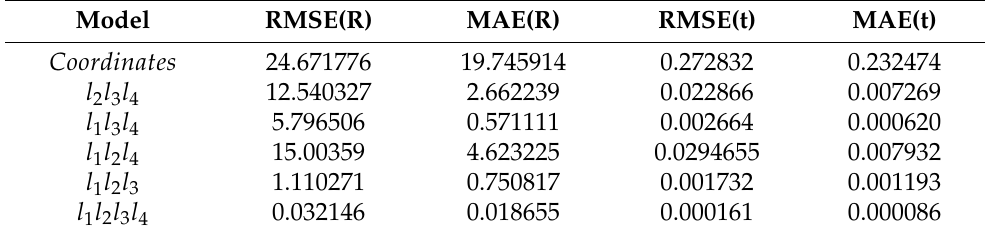
Table 5. Test results on the effectiveness of TIF.